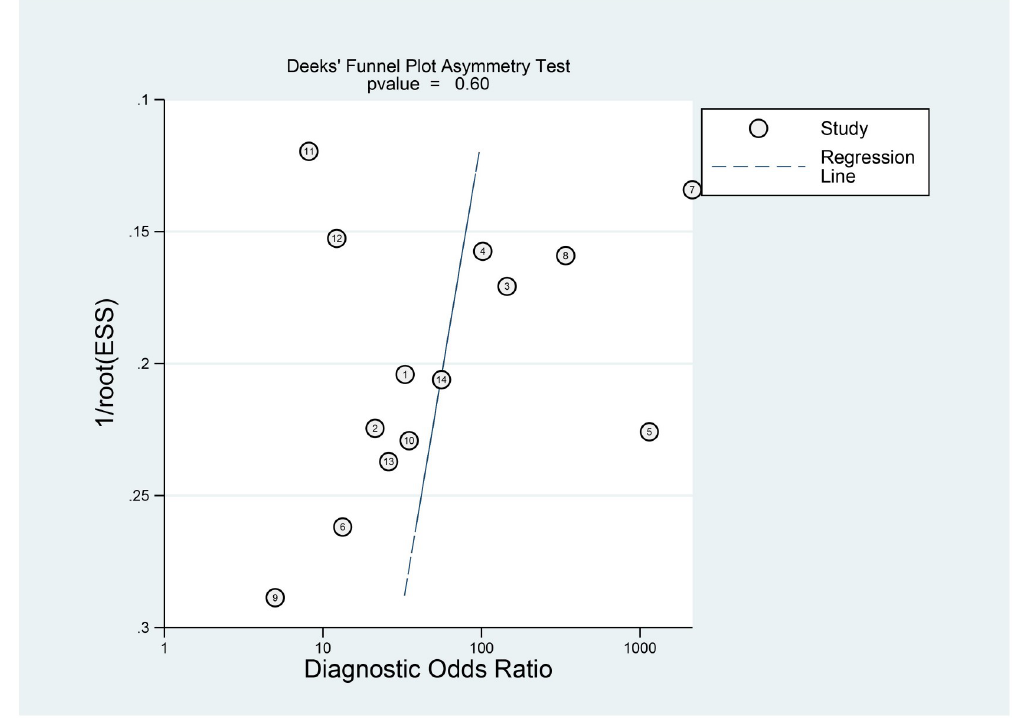
Fig 6. Funnel plot of the diagnostic value of